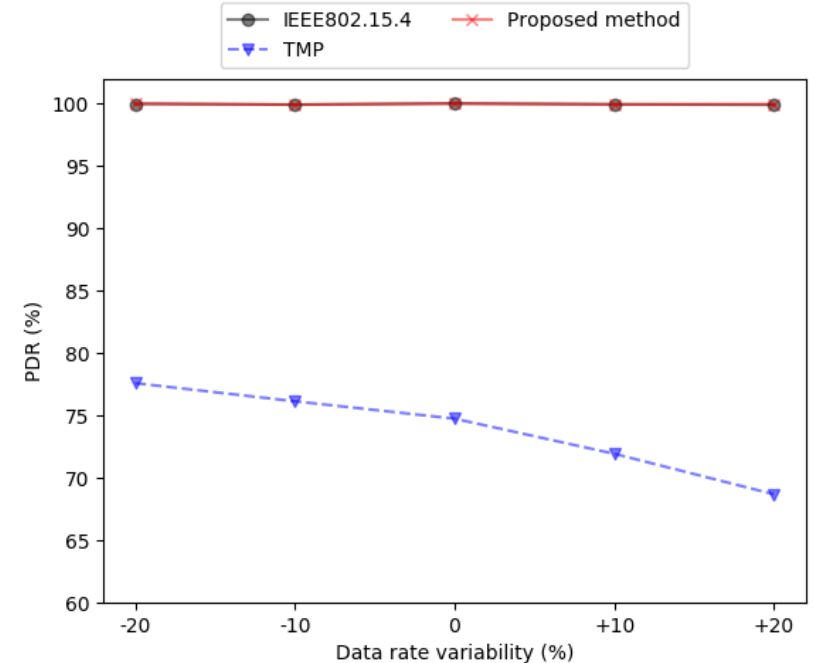
Figure 15. Sensitivity analysis of PDR.